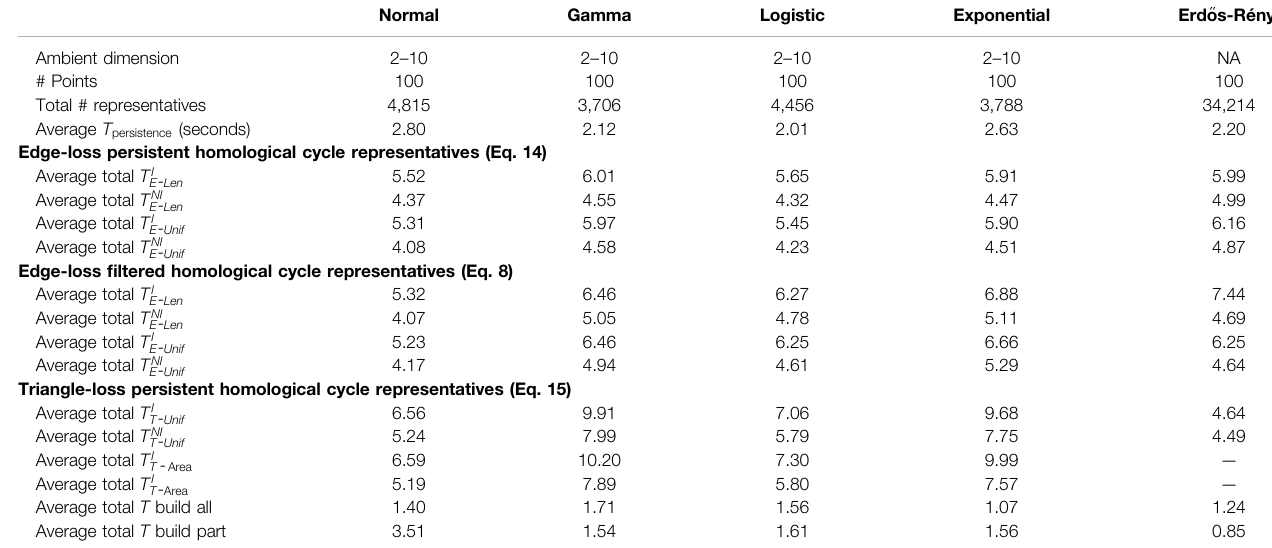
TABLE2| Summaryoftheexperimentalresultsforthesynthetic,randomlygenerateddatasetsdescribedin Section5.2 and Section5.3 .Foreachdistribution,wesample 10 data sets each containing 100points in ambient dimensions from 2 – 10. The computation time in this table averages the 10 random samples for each dimension and distribution combination. The number of cycle representatives is totaled over the 90 samples for each distribution. The rows of this table are analogous to those of Table 1 , excluding the penultimate row of that table, as the time comparison is only done for the large real-world data